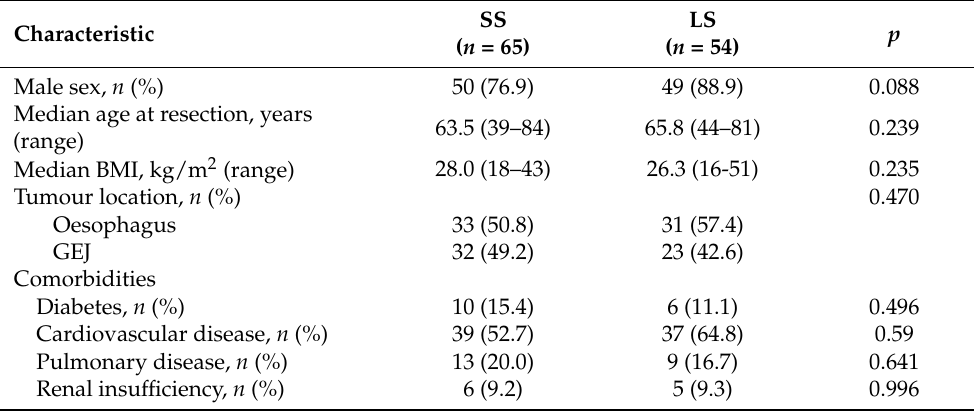
Table 1. Baseline demographics and clinical